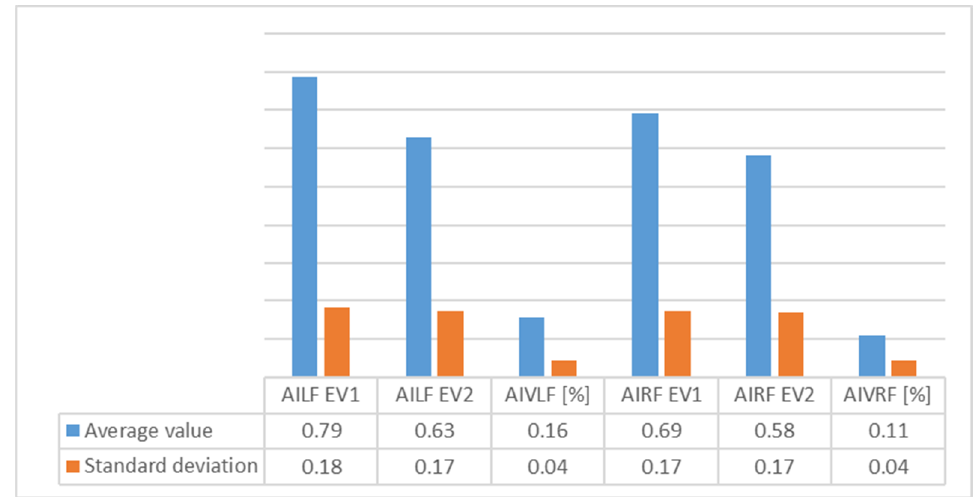
Figure 6. Variation of average values and standard deviation for plantar index arch for Group 2 between EV1 and EV2 (AILF = plantar index arch for left foot; AIVLF = plantar index arch variation for left foot; AIRF = plantar index arch for right foot; AIVRF = plantar index arch variation for right foot).